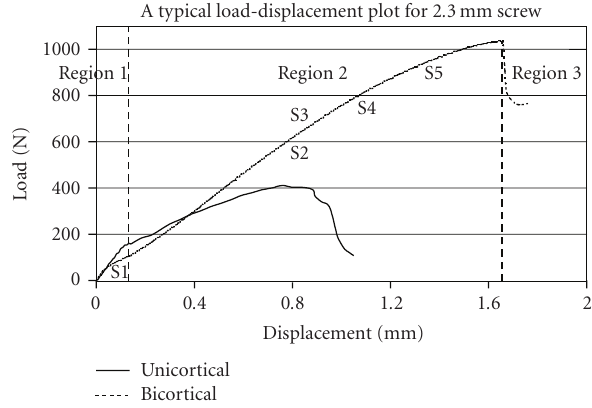
Figure 5: Graph showing typical load-displacement curves for bicortical and unicortical pull-outs. Results were taken for screws with a 2.3 mm major diameter and a 1.0mm pitch. Three di ff erent regions are denoted from which specimens were taken for polishing.